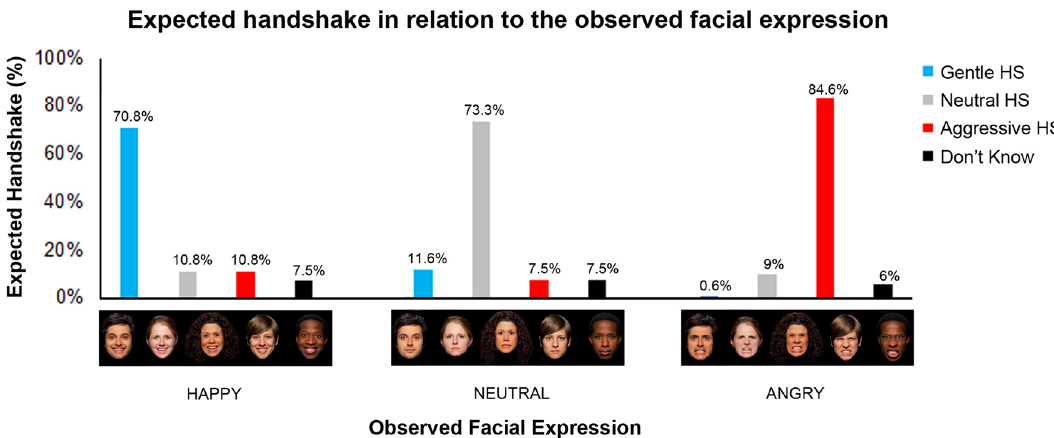
Figure 1. Graph shows the participants’ score indicating the type of handshake that they expected in association with the observation of happy, neutral and angry facial expressions. Under the graph is shown